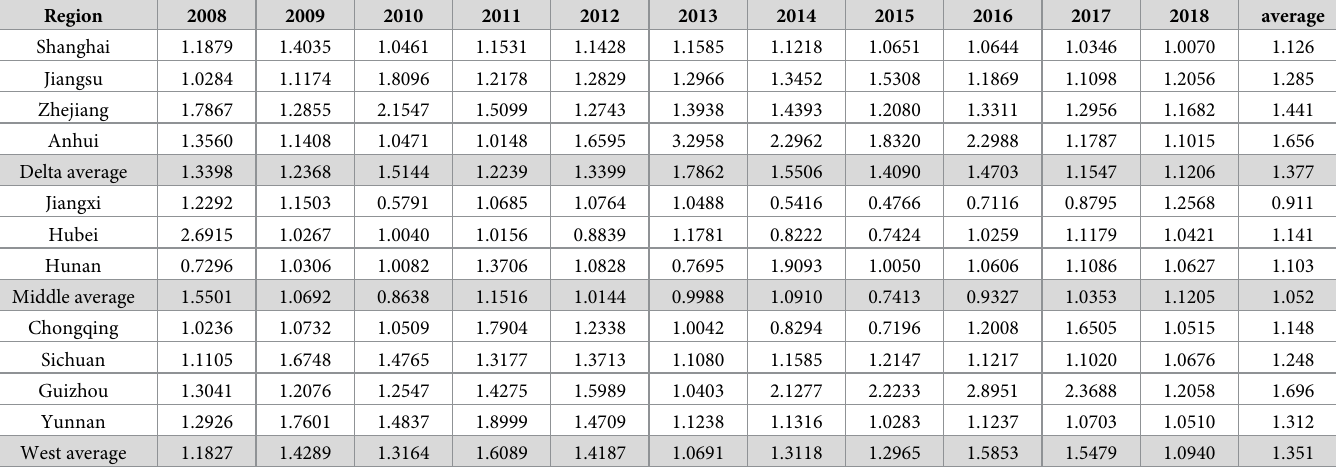
Table 2. Efficiency of university S&T achievements transformation in Yangtze River Economic